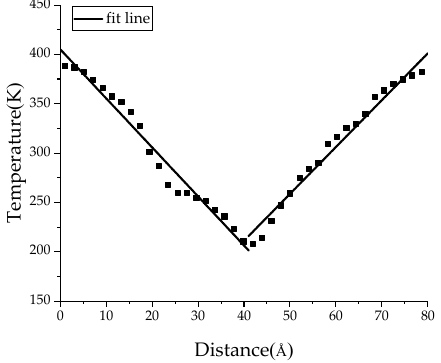
Figure 9. Temperature variation along z -axis